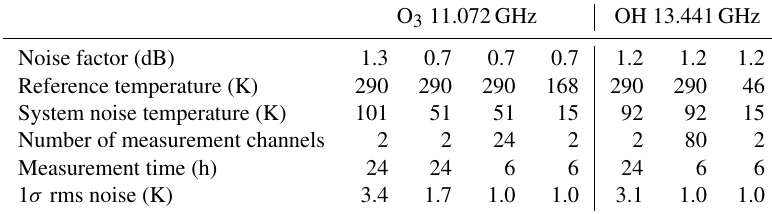
Table 1. Calculated performance for ozone (O 3 ) 11.072GHz and hydroxyl (OH) 13.441GHz radiometers with 10kHz frequency